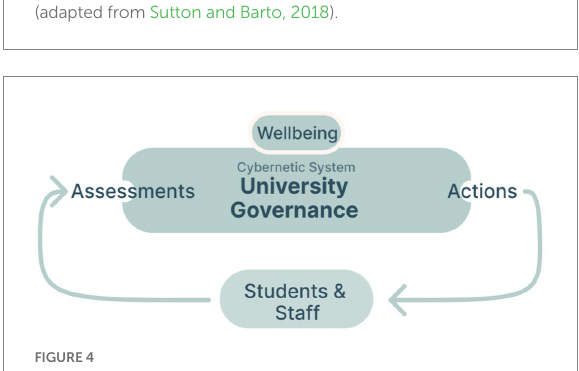
FIGURE 4 A schematic that visualizes the different components that were involved in the feedback loops in our context.